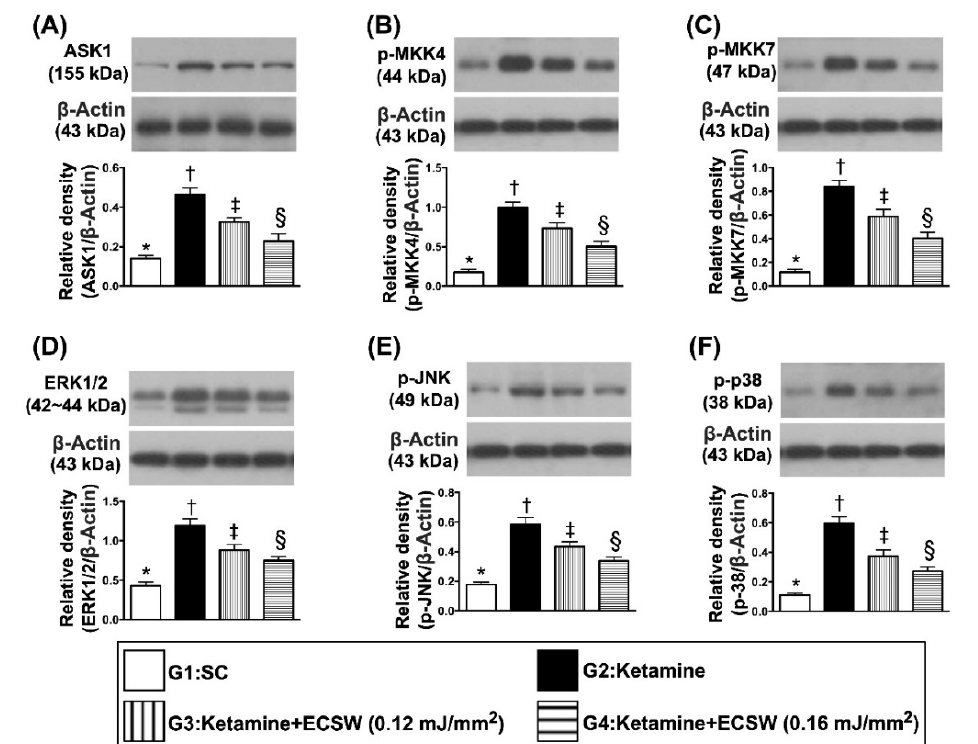
Figure 11. ECSW therapy regulated the protein levels of cell-stress response signalings in rat urinary bladder by day 42 after ketamine administration. ( A ) Protein expression of ASK1, * vs. other groups with different symbols (†, ‡, §), p < 0.0001. ( B ) Protein expression of p-MKK4, * vs. other groups with different symbols (†, ‡, §), p < 0.0001. ( C ) Protein expression of p-MKK7, * vs. other groups with different symbols (†, ‡, §), p < 0.0001. ( D ) Protein expression of ERK1/2, * vs. other groups with different symbols (†, ‡, §), p < 0.0001. ( E ) Protein expression of p-JNK, * vs. other groups with different symbols (†, ‡, §), p < 0.0001. ( F ) Protein expression of p-p38, * vs. other groups with different symbols (†, ‡, §), p < 0.0001. All statistical analyses were performed by one-way ANOVA, followed by Bonferroni multiple comparison post hoc test ( n = 6 for each group). Symbols (*, †, ‡, §) indicate significance (at 0.05 level). ECSW = extracorporeal shock wave.